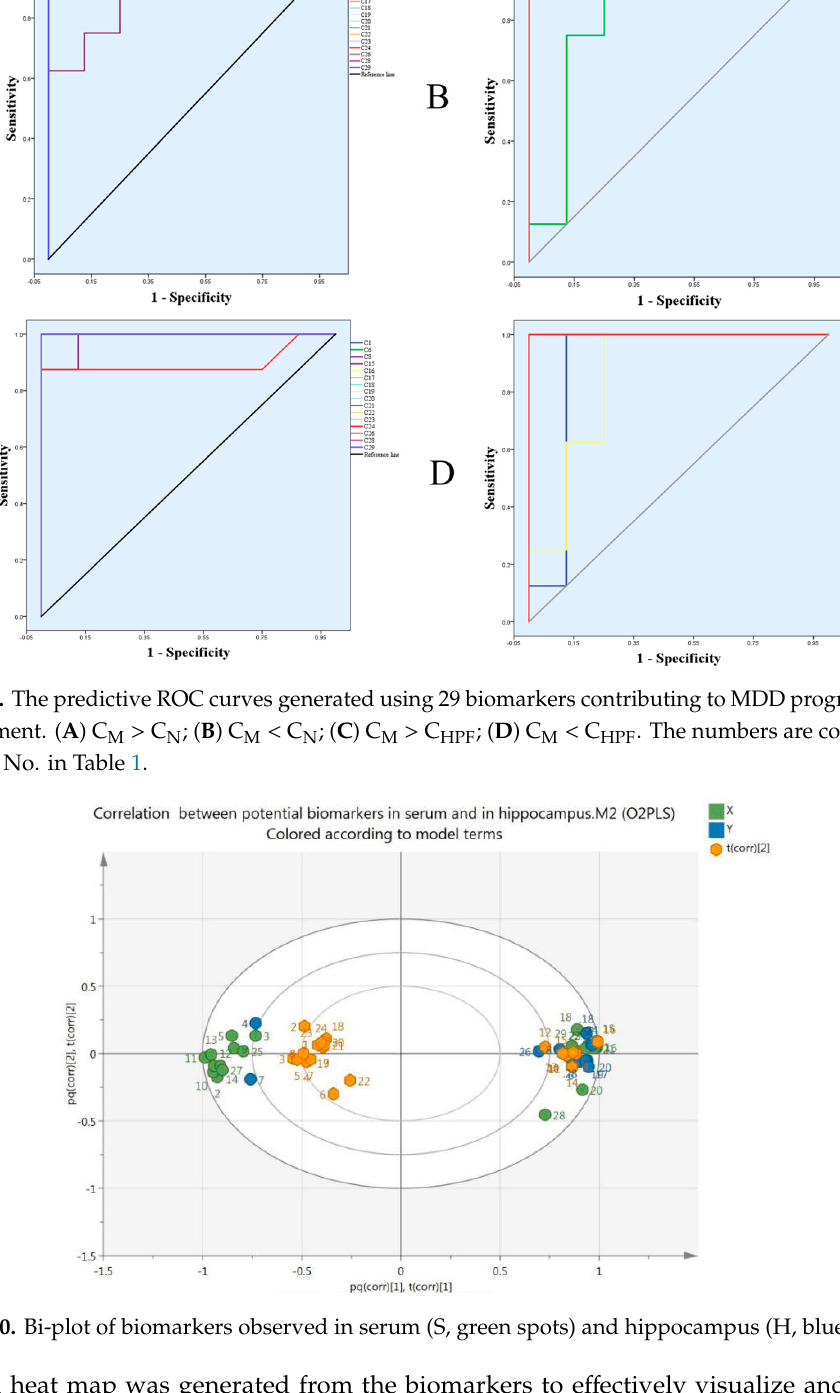
Figure 10. Bi-plot of biomarkers observed in serum (S, green spots) and hippocampus (H, blue spots).